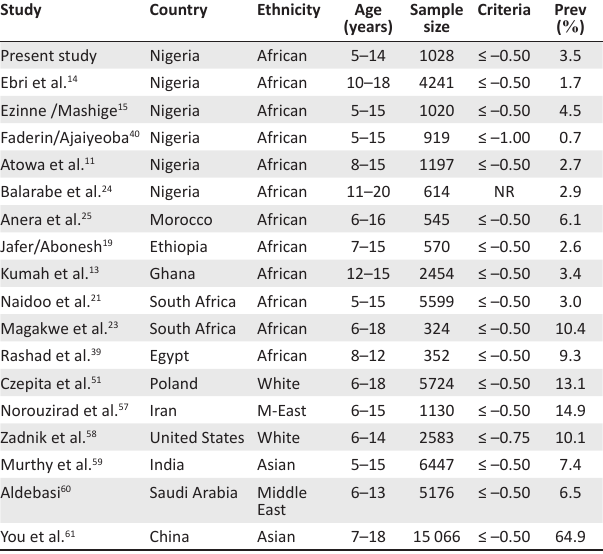
TABLE 5: Prevalence of myopia in the present study compared to African countries and the rest of the world. Study